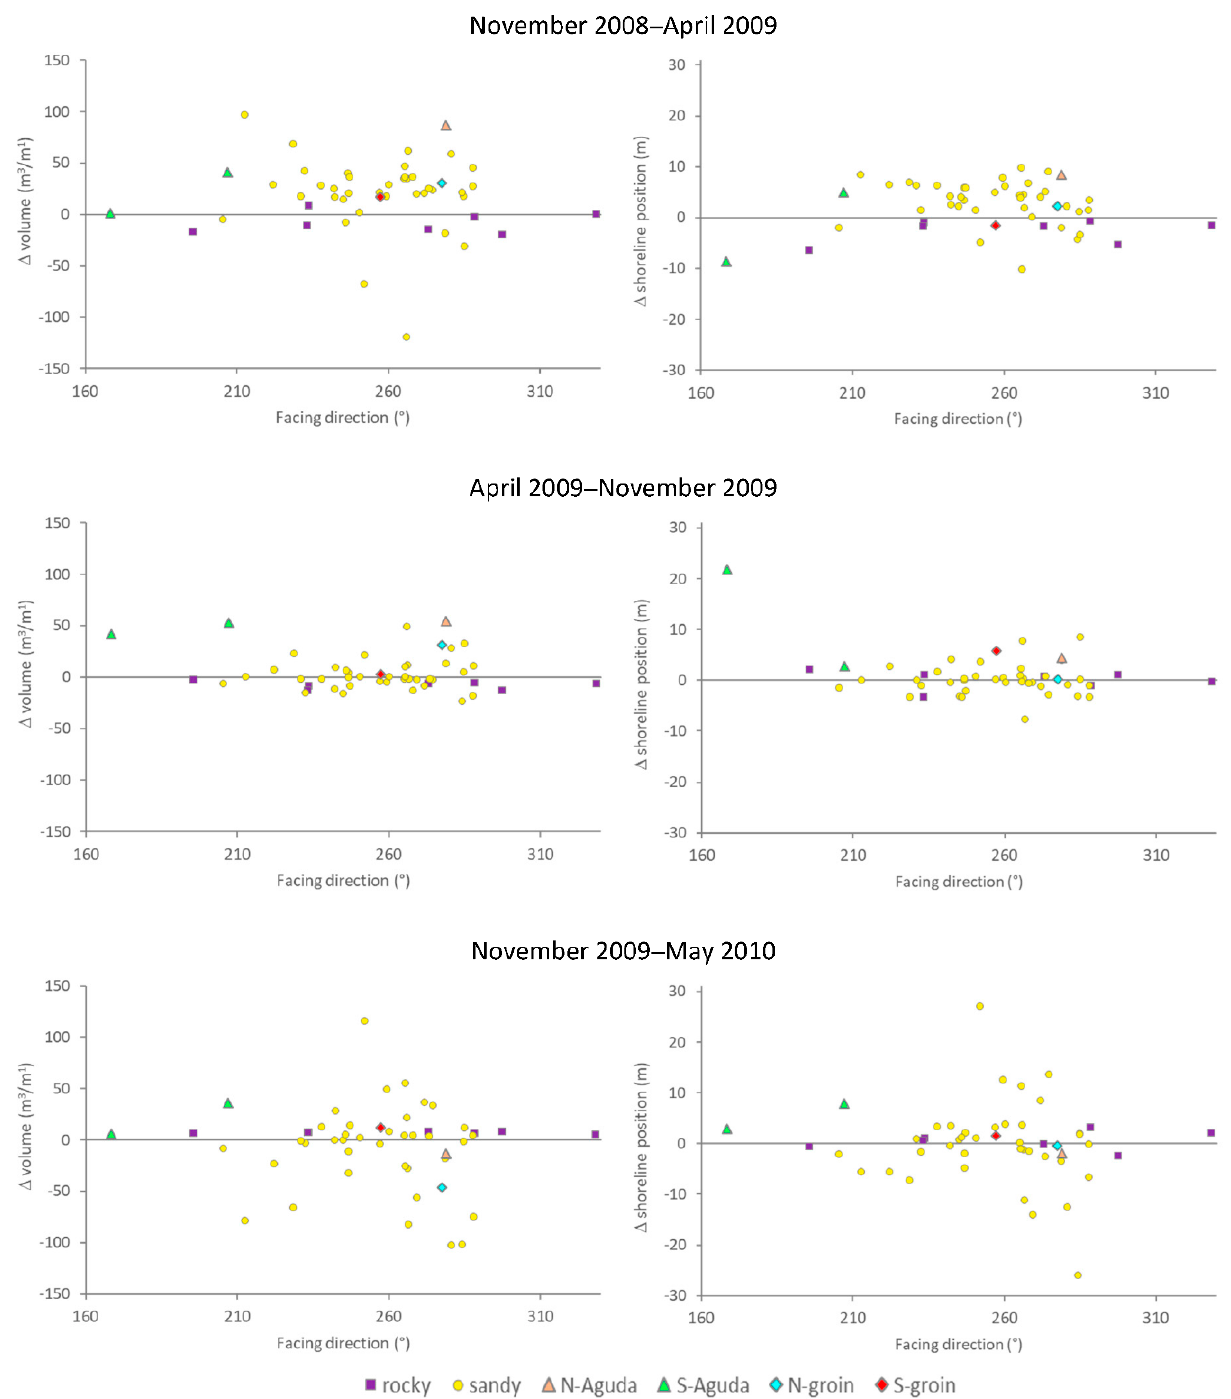
Figure 14. Seasonal changes in volume and shoreline position per segment presented according to segment orientation and marked according to the segment type or its location (N-Aguda: segment 40 north of the Aguda breakwater, S-Aguda: segments 43 and 44 south of the Aguda breakwater, N-groyne: segment 13 north of the groyne, S-groyne: segment 15 south of the groyne).